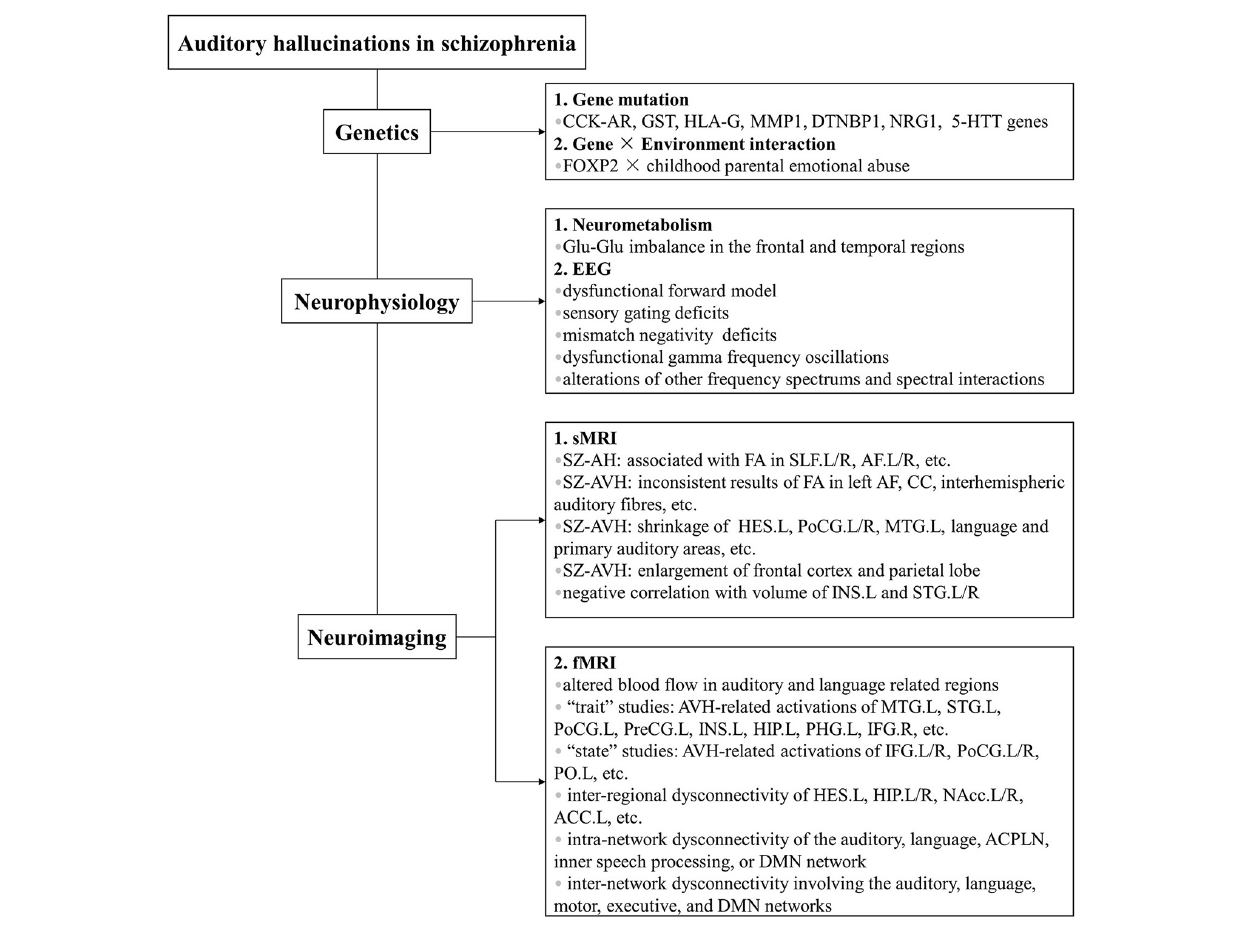
FIGURE 1 | Etiology of auditory hallucinations in schizophrenia from multidimensional levels. Previous work has utilized methods of various kinds, including genetic, neurophysiological, and neuroimaging studies. Main findings are summarized in the figure. Abbreviations: CCK-AR, cholecystokinin A receptor; GST, glutathione S-transferase; HLA-G, human leukocyte antigen-G; MMP1, matrix metalloproteinase 1; DTNBP1, dystrobrevin binding protein 1; NRG1, neuregulin 1; 5-HTT, serotonin transporter; FOXP2, forkhead box P2; EEG, electroencephalogram; sMRI, structural magnetic resonance imaging; SZ-AH, schizophrenia with auditory hallucinations; FA, fractional anisotropy; L, left; R, right; L/R, bilateral; SLF, bilateral superior longitudinal fasciculi; AF, arcuate fasciculi; SZ-AVH, schizophrenia with auditory verbal hallucinations; CC, corpus callosum; HES, Heschl’s gyrus; PoCG, postcentral gyrus; MTG, middle temporal gyrus; INS, insula; STG, superior temporal gyrus; fMRI, functional magnetic resonance imaging; PreCG, precentral gyrus; HIP, hippocampus; PHG, parahippocampal gyrus; IFG, inferior frontal gyrus; PO, parietal operculum; NAcc, nucleus accumbens; ACC, anterior cingulate cortex; ACPLN, auditory cortex-posterior language network; DMN, default mode